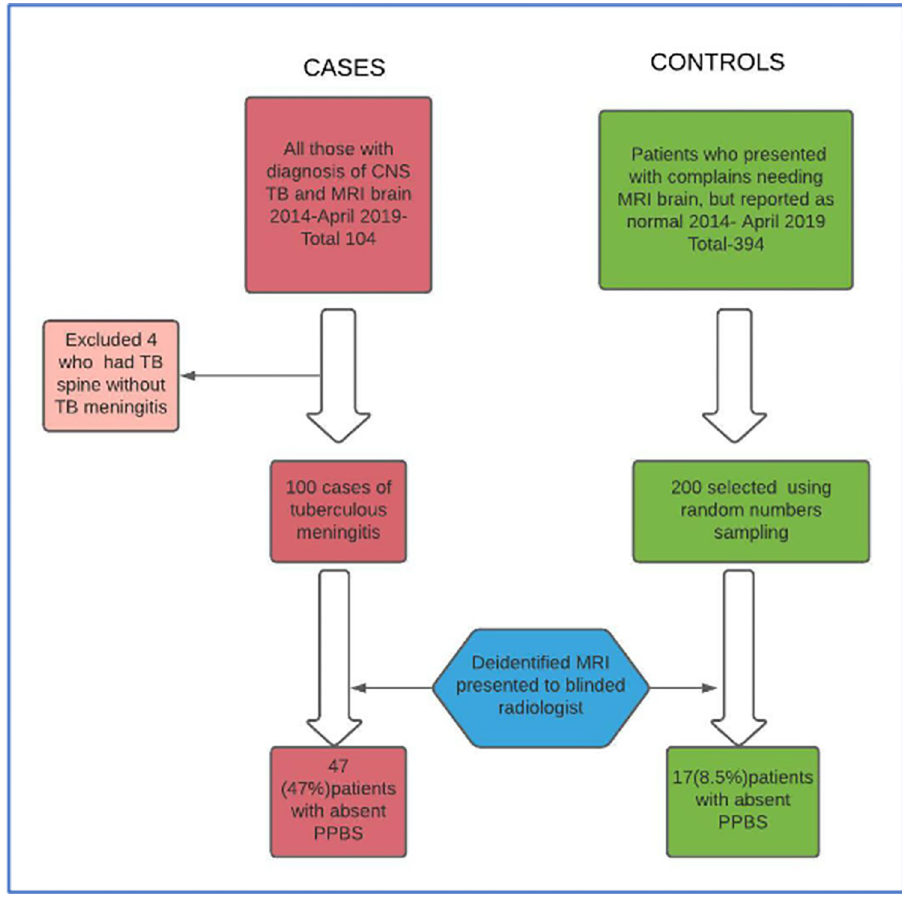
Fig 2. STROBE flow diagram.